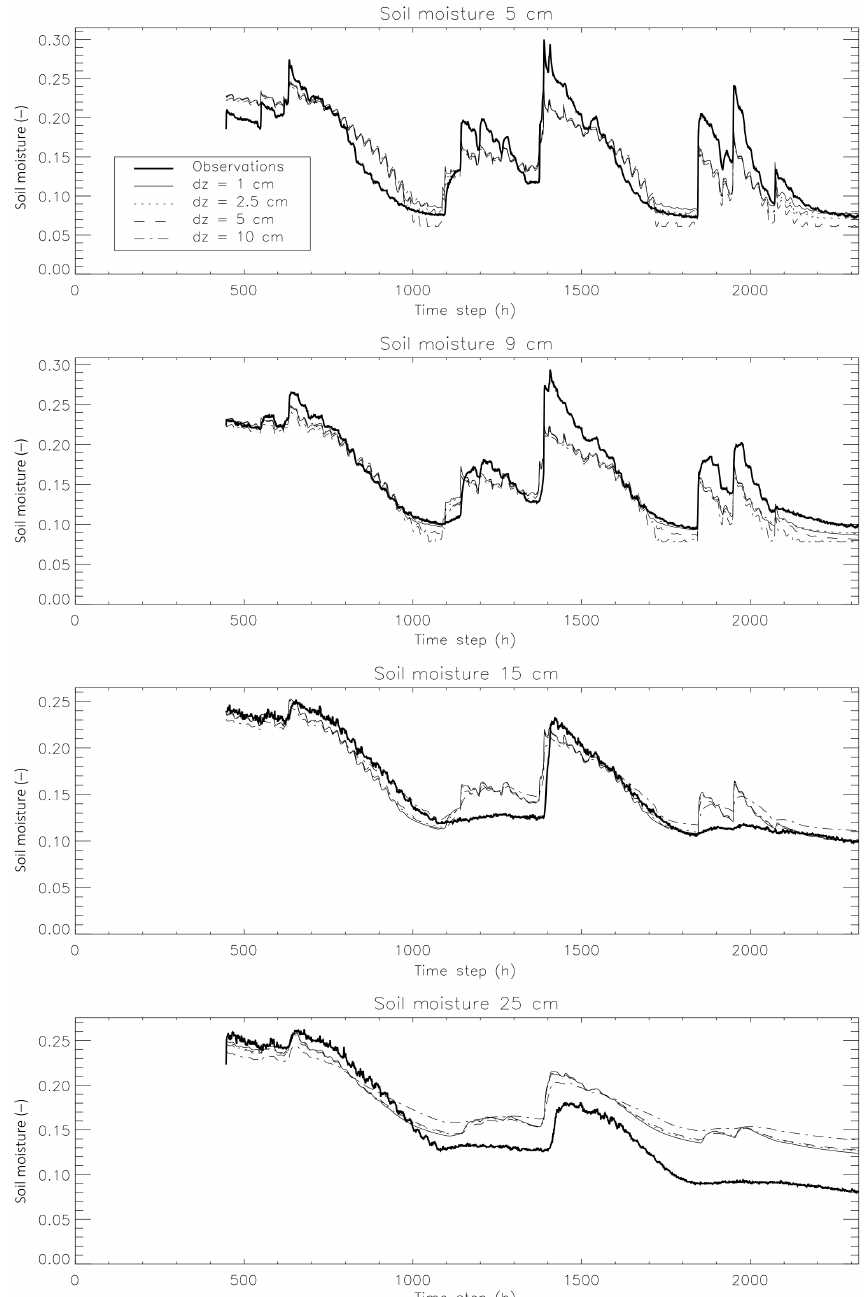
Figure 2. Comparison between the modeled and the observed soil moisture values for the four different spatial resolutions, and a numerical solution of the heat conduction equation. The model results for all four spatial resolutions are very similar and therefore difficult to distinguish.